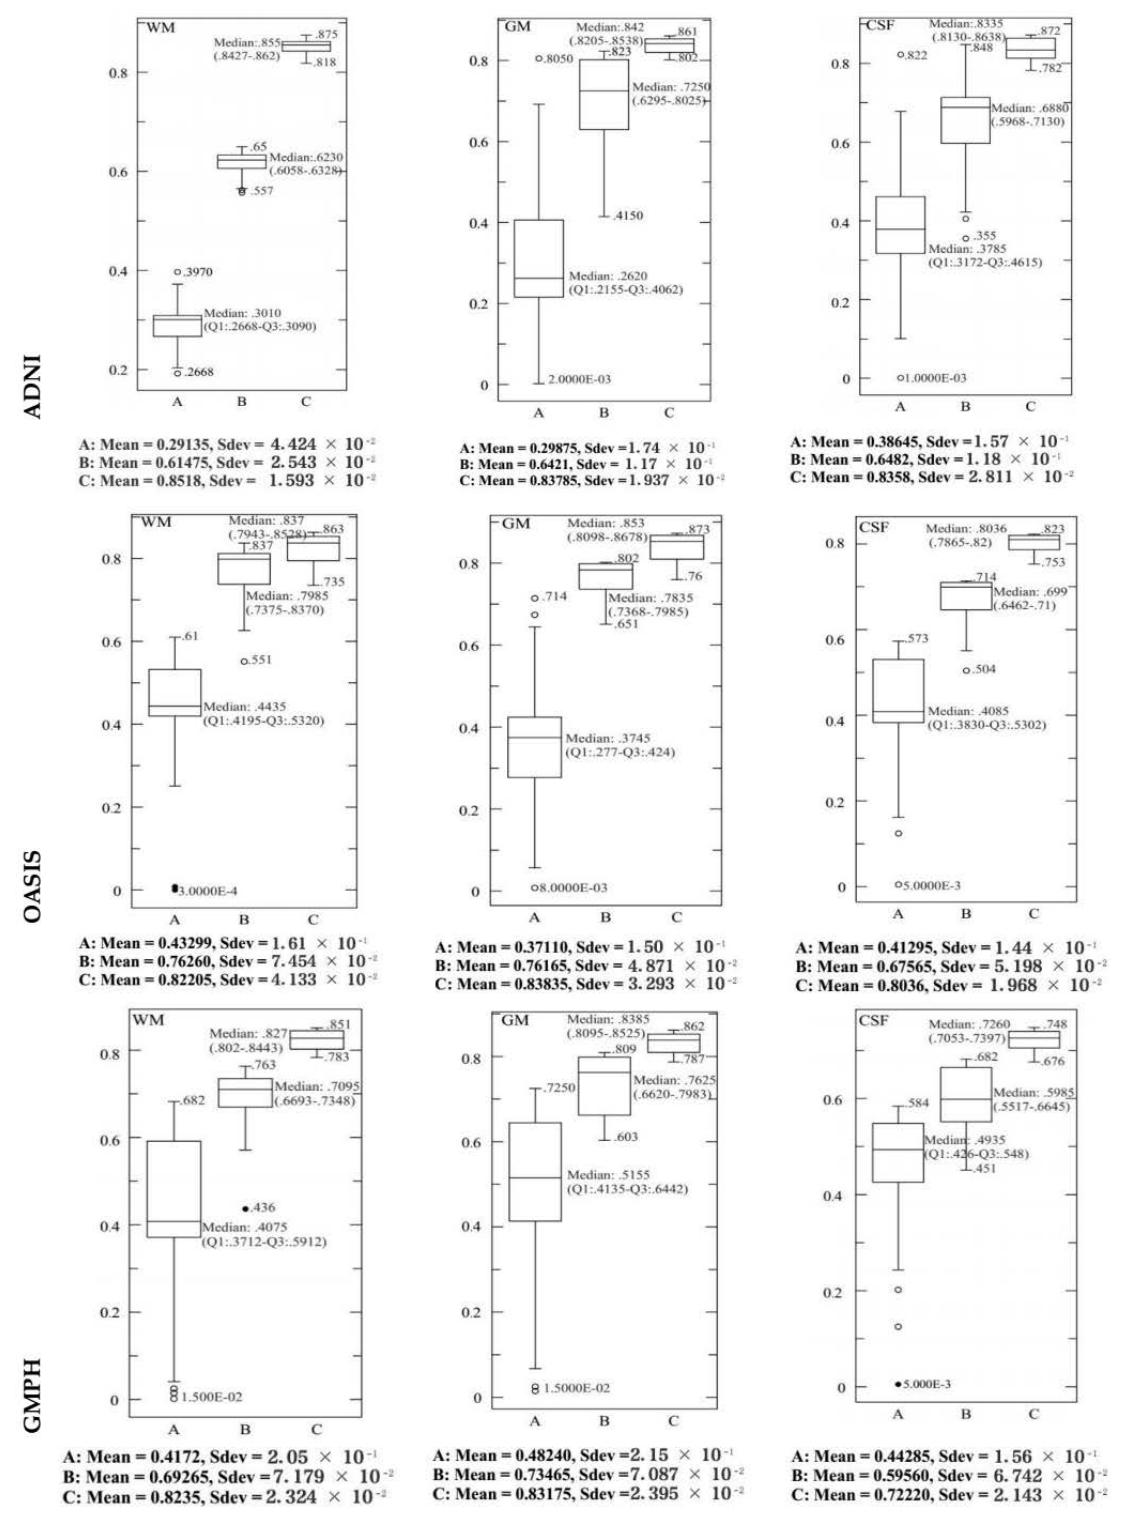
Figure 11. The corresponding Box-and-whisker plots of the descriptive statistics of the measured TC values (95% confidence interval) for WM, GM and CSF tissues with 20% additive noise. 20 experiences are used to evaluate the following modelling approaches: BCFCM / GA / PFCM ( C ), BCFCM / GA / FPCM ( B ) and BCFCM / GA / PCM ( A